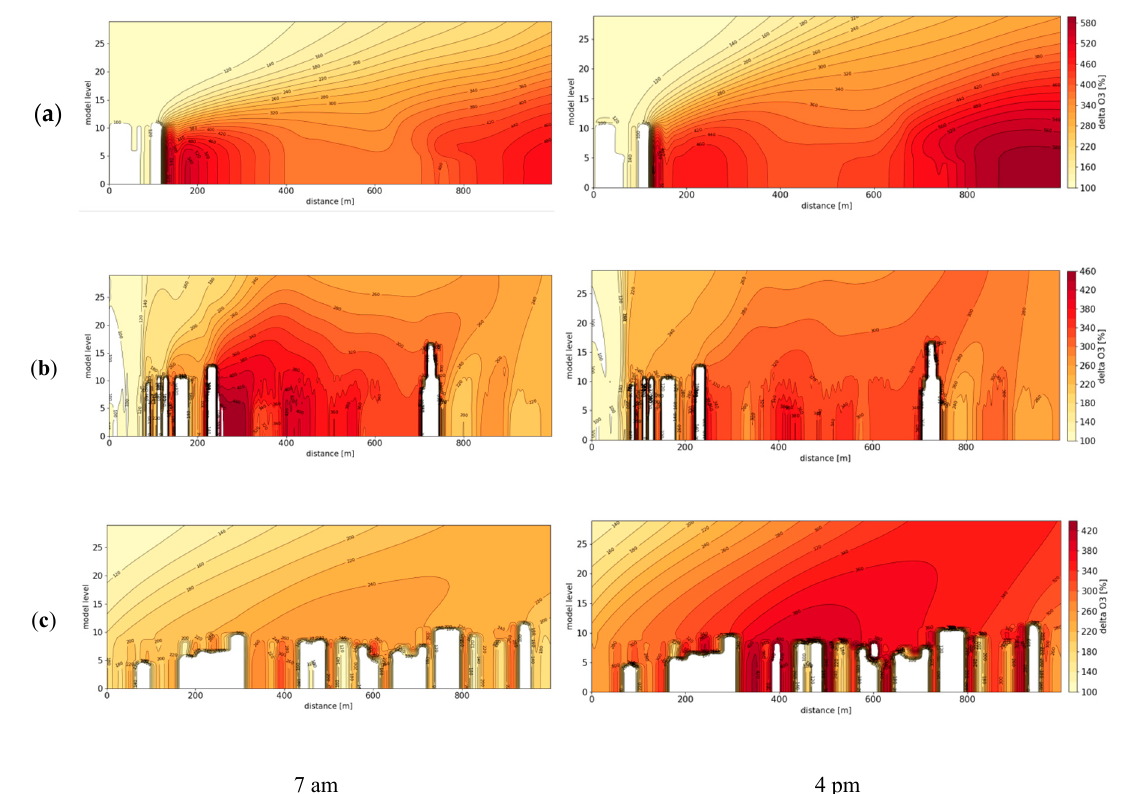
Figure 13. Cross-section, as indicated in Figure 12b, for relative change in ozone for ( a ) Box A, ( b ) Box B, and ( c ) Box C for (left) 7 am and (right) 4 pm, with white areas representing buildings and a distance of 1200 points and a vertical distance of 90 horizontal distance of 1200 points and a vertical distance of 90 m.